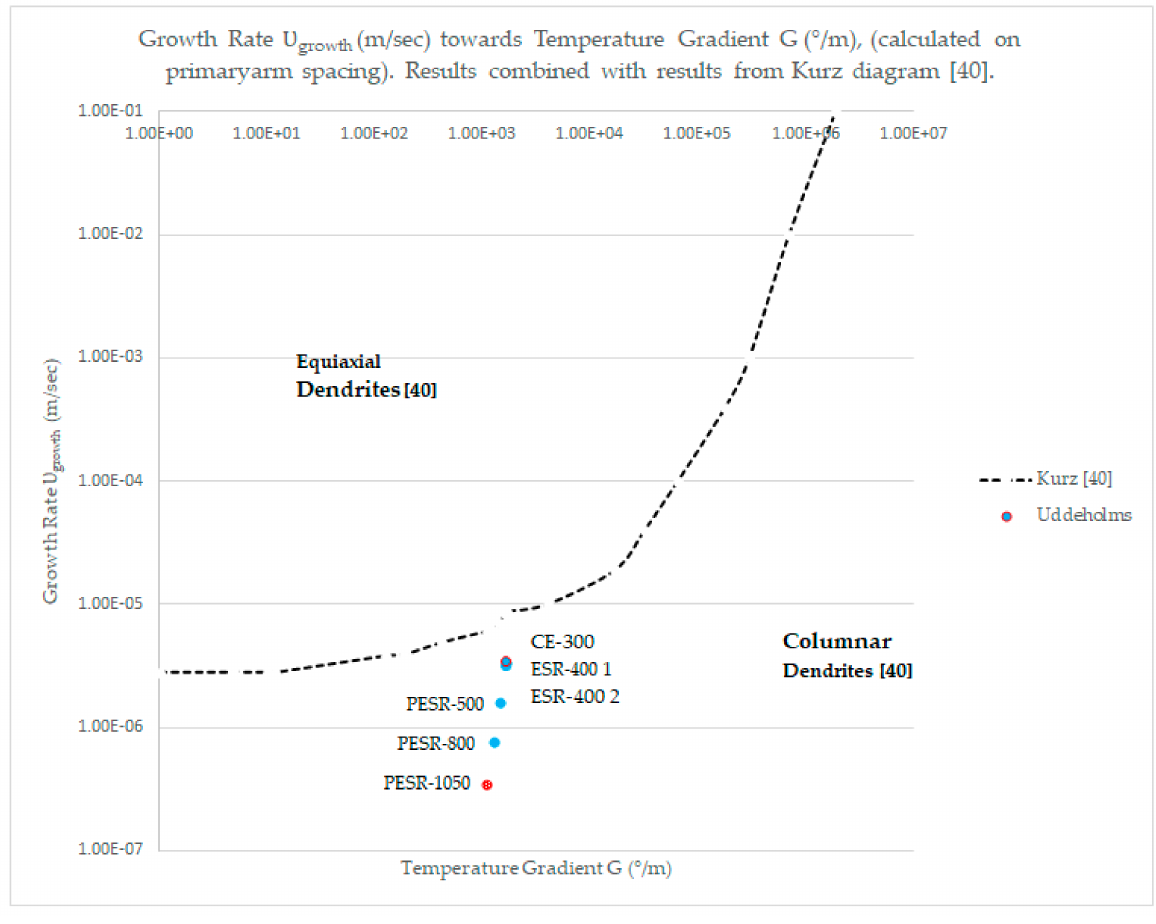
Figure 14. Growth rate Ʋ growth (m/s) (calculated on primary dendrite arm spacings) versus the temperature gradient G (°C/m) around the solid/liquid tip. The black line is plotted data from Kurz solidification diagram [40]. The area above the line solidifies in an equiaxial manner and the area below solidifies in a columnar-dendritic manner [40]. Data from Uddeholms martensitic stainless steel are included, the electrode 300 × 300 mm 2 , (CE-300), the electro-slag remelted ingots 400 × 400 mm 2 , (ESR-400), and the pressure electro-slag remelted ingots 500–1050 mm in diameter, (PESR-500, PESR-800, and PESR-1050). All data are from the center position of the ingots. The electrode and the PESR-1050, which solidify equiaxial dendritic in the center, are marked (●), because the equations used are not valid for the equiaxial solidification structure.